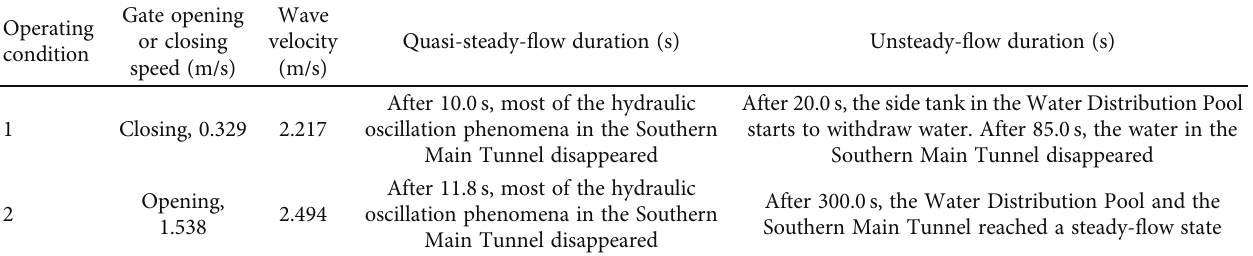
Table 1: Statistical table of hydraulic characteristic parameters in the Huangchigou Water Distribution